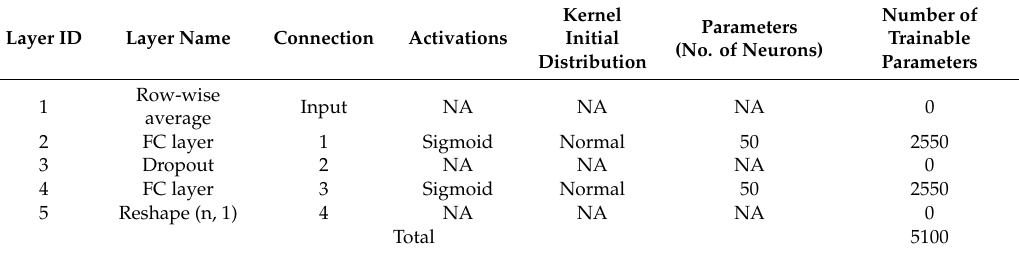
Table 7. Residual attention U-net (ResAUnet)